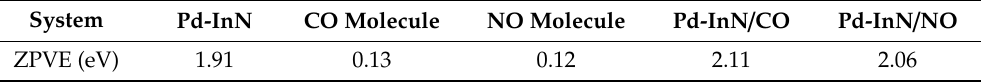
Table 1. ZPVE of Pd-InN monolayer, gas molecules and adsorbed